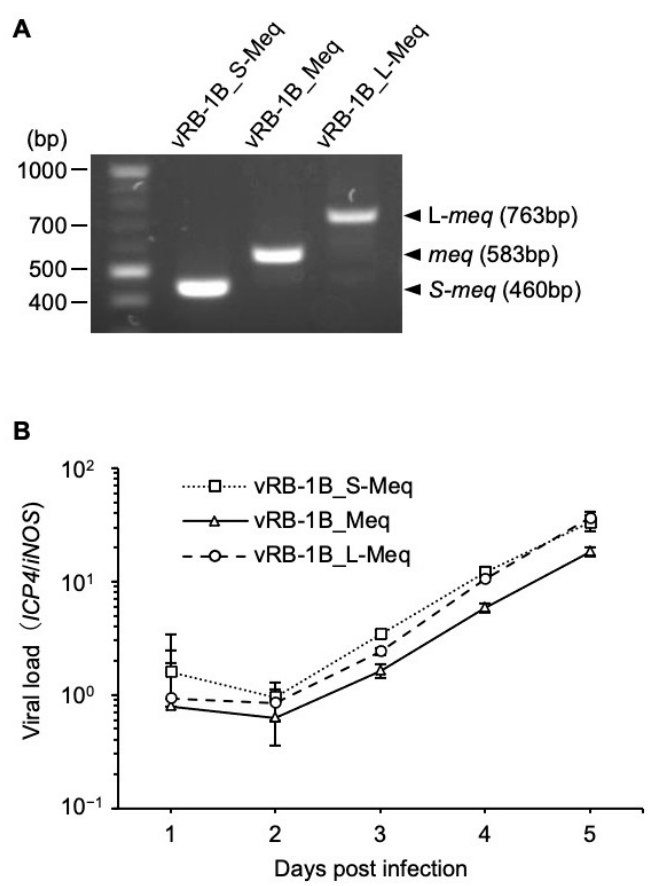
Figure 3. Expression analysis and replication of recombinant MDVs in cell culture. ( A ) mRNA expression of each meq -isoform in chicken embryo fibroblasts (CEFs) infected with vRB-1B_S-Meq, vRB-1B_Meq, and vRB-1B_L-Meq was confirmed by reverse transcription-polymerase chain reaction (PCR). ( B ) CEFs were infected with 50 plaque-forming units of recombinant Marek’s disease viruses. The infected cells were collected daily for 6 days. The viral loads in the infected cells were analyzed by quantitative PCR. The growth kinetics among the groups were analyzed using the Kruskal–Wallis test.